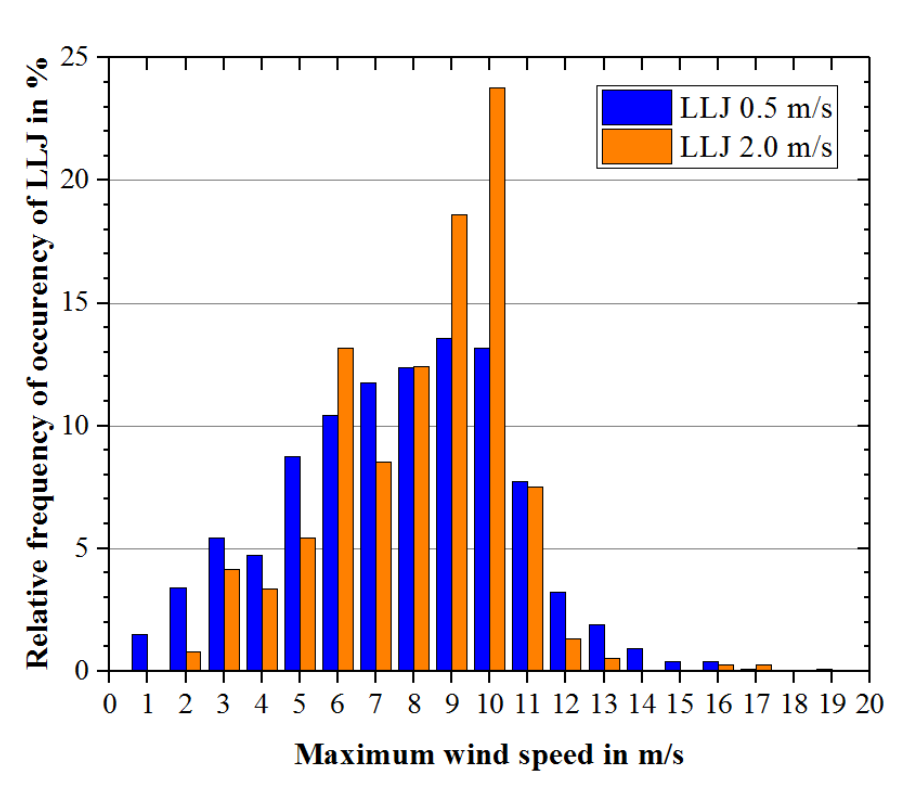
Figure 3. Comparison of LLJ events according to the criteria of 2ms − 1 (orange) and 0.5ms − 1 (blue) for the months June, July and August